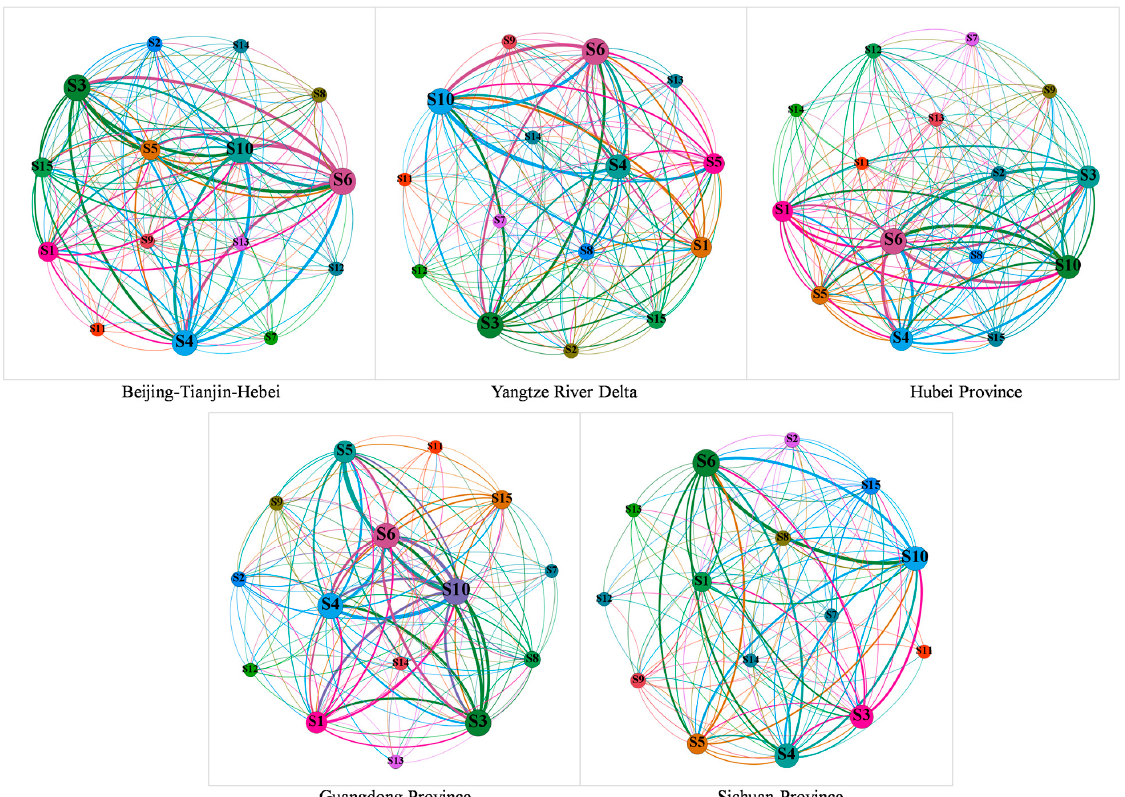
Figure 12. The semantic change networks in five areas.